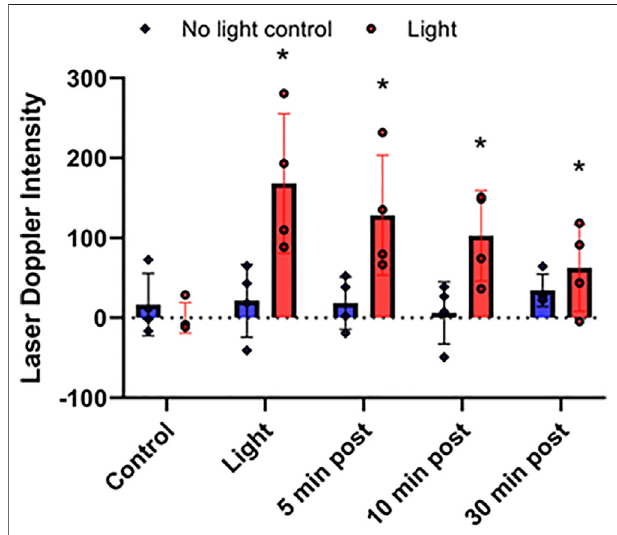
FIGURE 4 | Stability of red light-dependent vasodilator. 670 nm light was applied at 50 mW/cm 2 for 10 min on right limb of C57BI/6 mice with blood fl owwasmeasuredwithLaserDopplerImaging.Differencebetweenthe irradiated and non-irradiated limbs. Vasodilation was assessed at 0, 5, 10,and30 minafter fi nishingtheirradiation.Mean±SDisdenoted.Therewas no signi fi cant difference in the “ No light control ” groups (the adjusted P-value by the step-down Bonferroni procedure is 0.3989). In the “ Light ” group for each time point, there was a signi fi cant difference compared to control (adjusted p = 0.0189, 0.0189, 0.0330, and 0.0017,